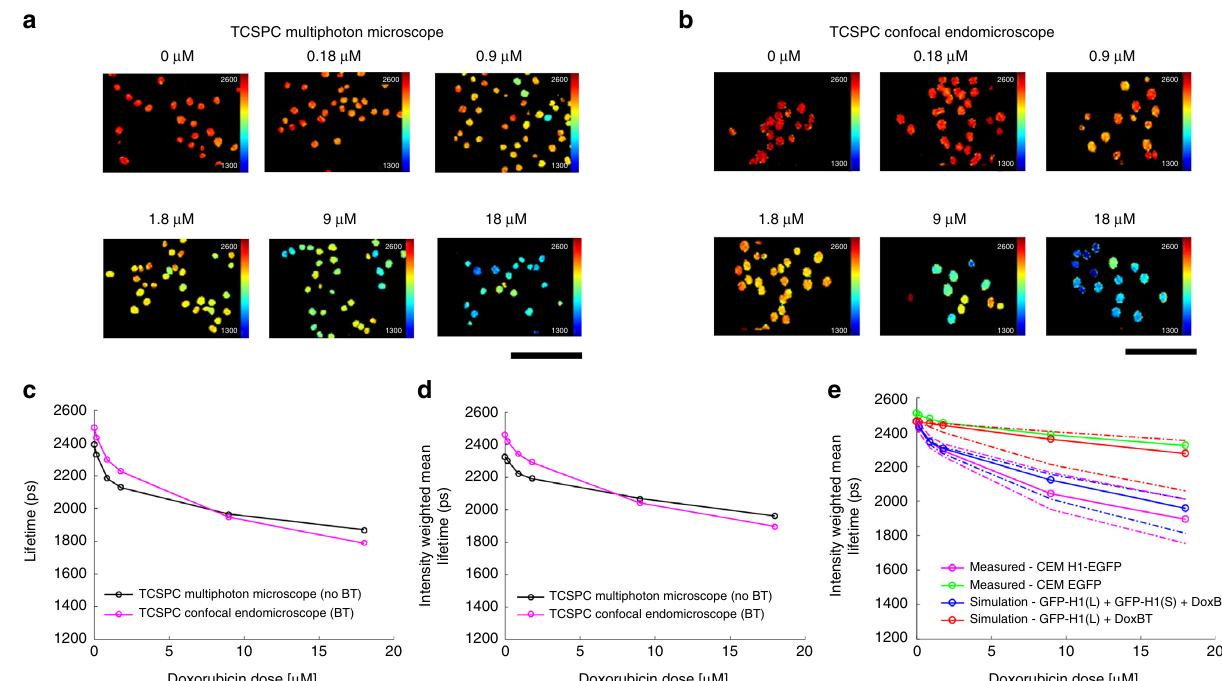
Fig. 3 In vitro fl uorescence lifetime measurement of GFP bound to chromatin for range of doxorubicin concentrations. a Exemplar fl uorescence lifetime images of IGROV-1 cells with stable expression of histone H1-EGFP treated with a range of doxorubicin concentrations (0, 0.18, 0.9, 1.8, 9, 18 µ M) for 3 h then fi xed, washed and imaged with the multiphoton LSM (scale bar is 120 µ m). For each concentration 3 or more fi elds-of-view (containing a total of >100 nuclei) were acquired. b Exemplar fl uorescence lifetime images of the same samples as in a but acquired with the CEM (scale bar is 120 µ m). In a and b FLIM data was fi tted to a single exponential decay model (as discussed in the Methods section). c Plot shows the mean lifetime of segmented nuclei averaged over the mean fl uorescence lifetimes per segmented nucleus (i.e., average of values from pixel-wise fi tting to a single exponential decay model within a single nucleus) for each doxorubicin concentration; d plot shows the intensity-weighted mean H1-EGFP fl uorescence lifetimes obtained by global fi tting across the entire dataset (as discussed in the Methods section) to a double exponential decay model with the long lifetime component fi xed to the value obtained from cells expressing H1-EGFP when not treated with doxorubicin. For c and d black and magenta lines and circles represent the multiphoton LSM and CEM data, respectively. e plot shows only the globally fi tted intensity-weighted mean H1-EGFP lifetime for the experimental CEM FLIM data (magenta lines and circles) together with simulations of the measured lifetime dependence on doxorubicin concentration (as discussed in Supplementary Note 1) assuming no FRET but a bleed through (BT) contribution from doxorubicin fl uorescence (red line and circles) and H1-EGFP FRET with the BT contribution from doxorubicin fl uorescence (blue line and circles). The solid blue and red lines represent the simulated intensity-weighted mean lifetime values based on the median cell-wise measured contribution from doxorubicin fl uorescence in the CEM (see Supplementary Note 1). The dashed red and blue lines indicate simulated values based on the 25th and 75th percentiles of the measured contribution from doxorubicin fl uorescence. The magenta and green lines (measured intensity-weighted mean lifetime values) show the median (solid lines and circles) and 25th and 75th (dashed lines) percentile values of the distribution across all H1-GFP expressing cells and GFP expressing cells, measured EGFP fl uorescence lifetime. Using confocal LSM and